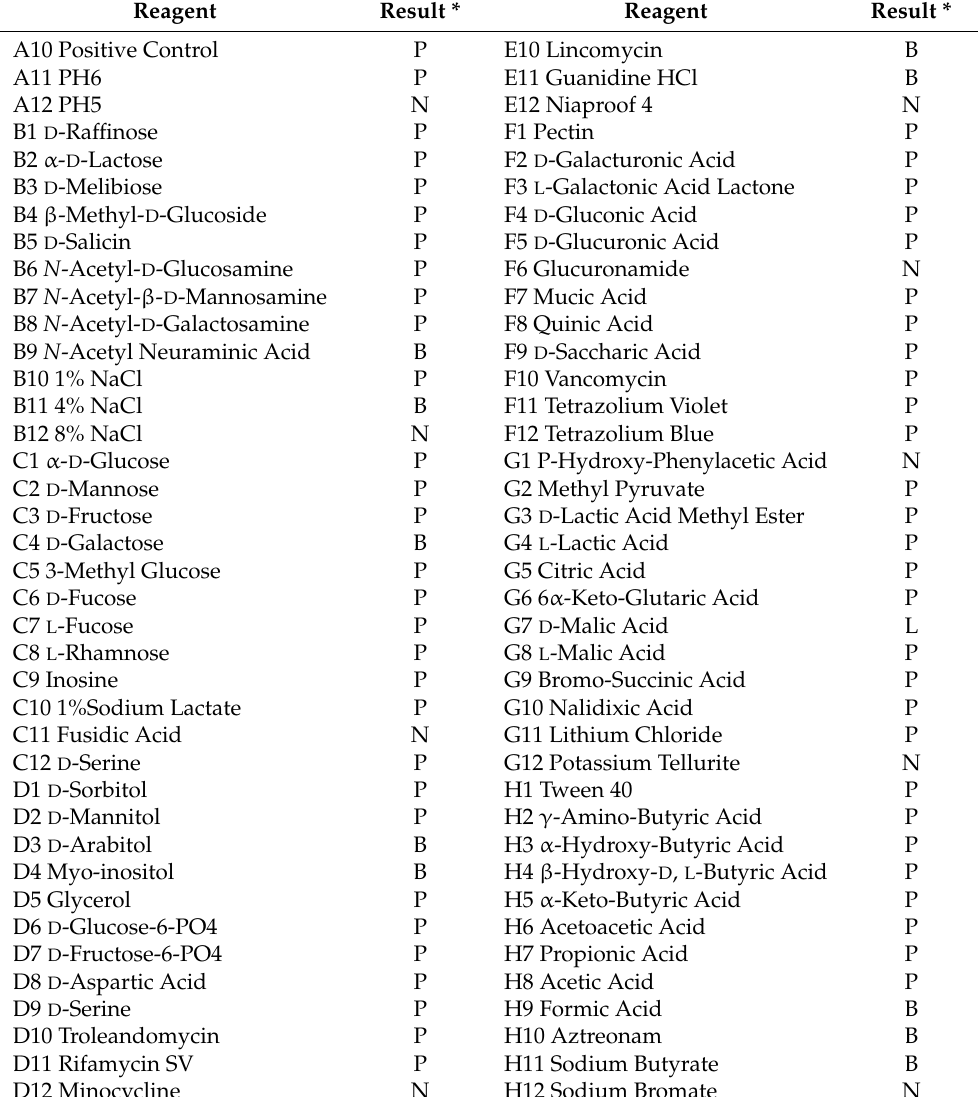
Table 2. Cont. Reagent Result *